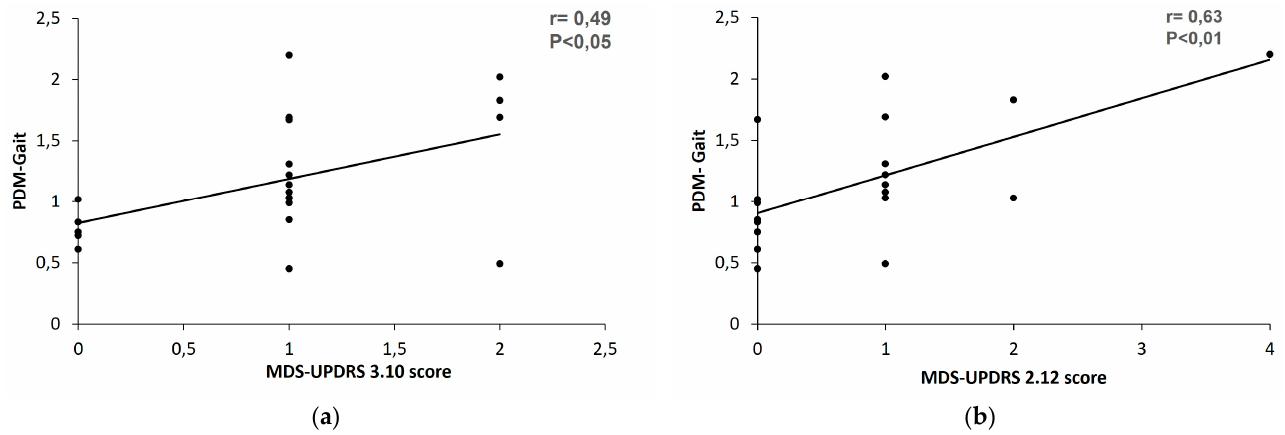
Figure 6. Correlation on gait between the PDMonitor ® score and the ( a ) MDS-UPDRS scores of item 3.10 (rater scored) and the ( b ) MDS-UPDRS scores of item 2.12 (patient scored) using Pearson’s correlation test.